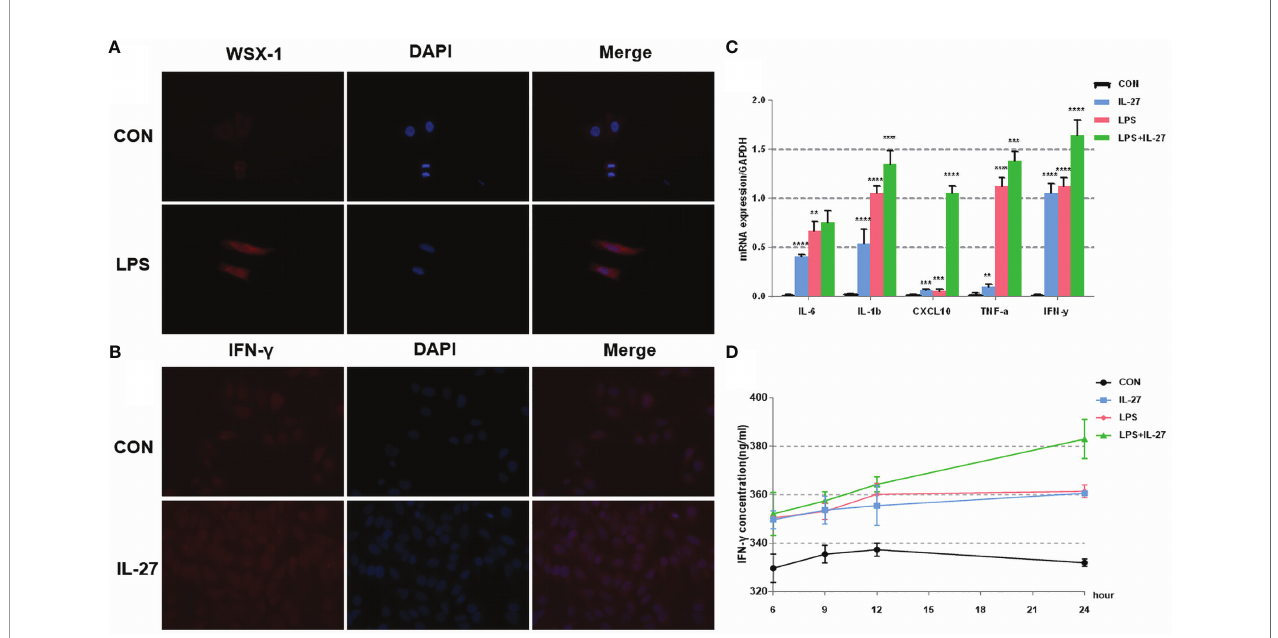
FIGURE 4 | The expression and localization of WSX-1 and the in fl ammatory effects induced by IL-27 in WISH cells. (A) immuno fl uorescence analysis of WSX-1 protein expression and localization in WISH cells treated for 6 h with PBS or with LPS (1 µg/ml). (B) relative expression levels of several key cytokines, including TNF- a , IL1 b , IL6, IFN- g , and CXCL10, from WISH cells treated for 6 h without (CON) or with LPS (1 µg/ml) or IL-27 (50 ng/ml) or both, as measured by qRT-PCR. (C) Immuno fl uorescence analysis of IFN- g protein expression and localization in WISH cells after IL-27 (50 ng/ml) treatment for 6 h (D) time-dependent effects of 50 ng/mL of IL-27, 1 µg/ml of LPS, or both of these factors, of those on the expression of IFN- g , as measured by ELISA. **P < 0.01, ***P < 0.001, ****P <